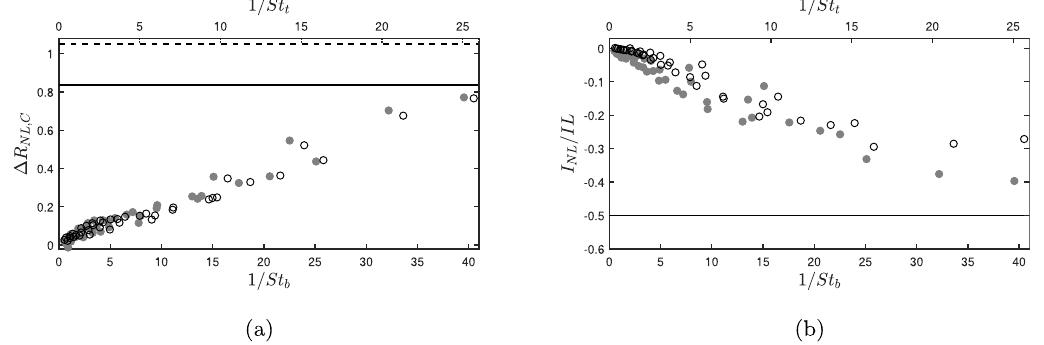
Figure 10. Change in a) slit resistance and b) slit inertance due to non-linearity for long ( ) and short ( ) slits as function of St b and St t for several amplitudes at the reference microphone ( ^ p x ref ð Þ (cid:10) 6 Pa). Lines are de fi ned as in Figure